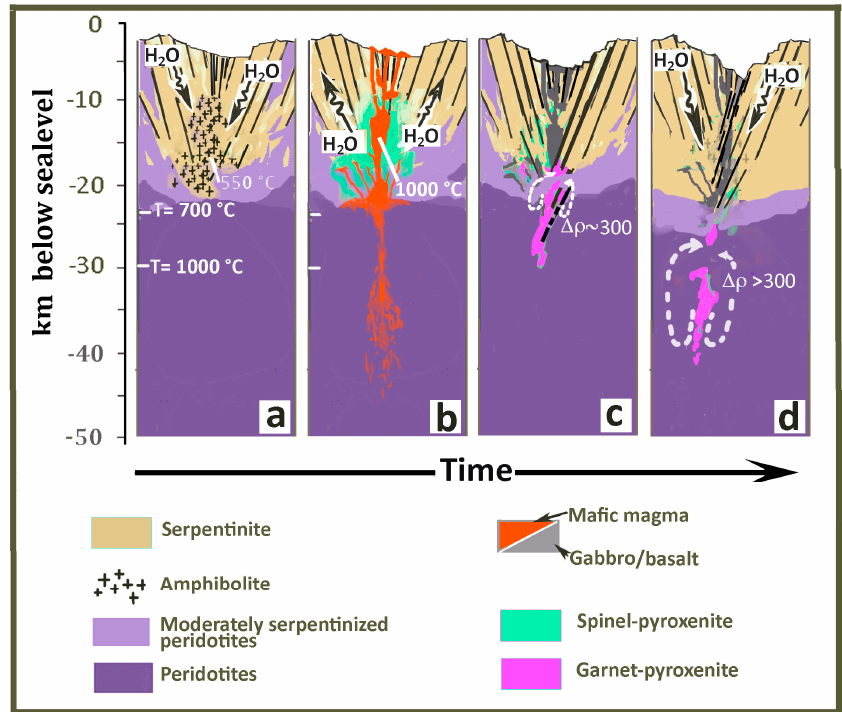
Figure 9. Cartoon showing a possible sequence of events, over undefined time (several Ma), in an imaginary ultra-slow spreading ridge geological section (not to scale). The basic context was roughly derived from [105]. The storyline stems from the results of the present paper. ( a ) An Al-rich amphibolite body, derived from the hydrothermal alteration of a troctolitic gabbro, is set in fractured serpentinite country rocks. ( b ) A transient increasing in temperature, due to an igneous intrusion, induces diffuse dehydroxylization and spinel-pyroxenite formation. ( c ) Re-equilibration of the spinel-pyroxenite minerals due to isobaric cooling induces garnet-growth and positive density contrast with the country rocks. Adequate rheological conditions give eventually rise to convective instability and ( d ) sinking of a large garnet-pyroxenite lump in the ductile mantle.